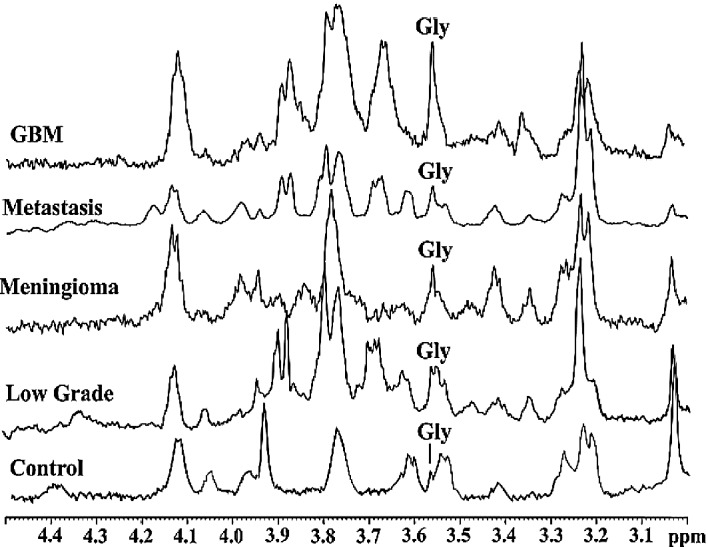
HRMAS 1H MR spectra using CPMG in control and brain tumor biopsies acquired with a TE of 50 ms. The Gly singlet at 3.55 ppm is labeled. MR spectra are scaled with respect to TSP signal (not shown here).